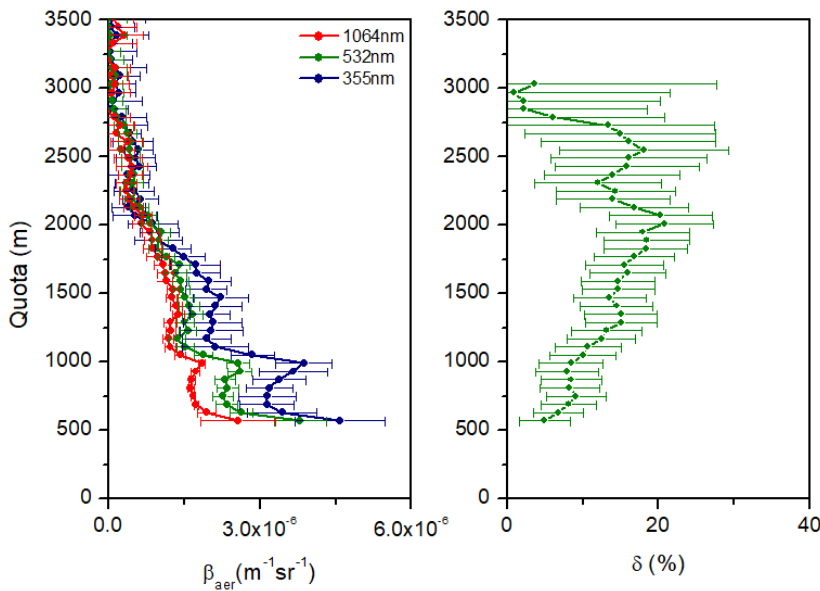
Figure 14. Lidar profiles of aerosol backscattering ( β a ) and linear depolarization ( δ a ) derived from diurnal lidar observations carried out on 12 July 2017 in Naples.